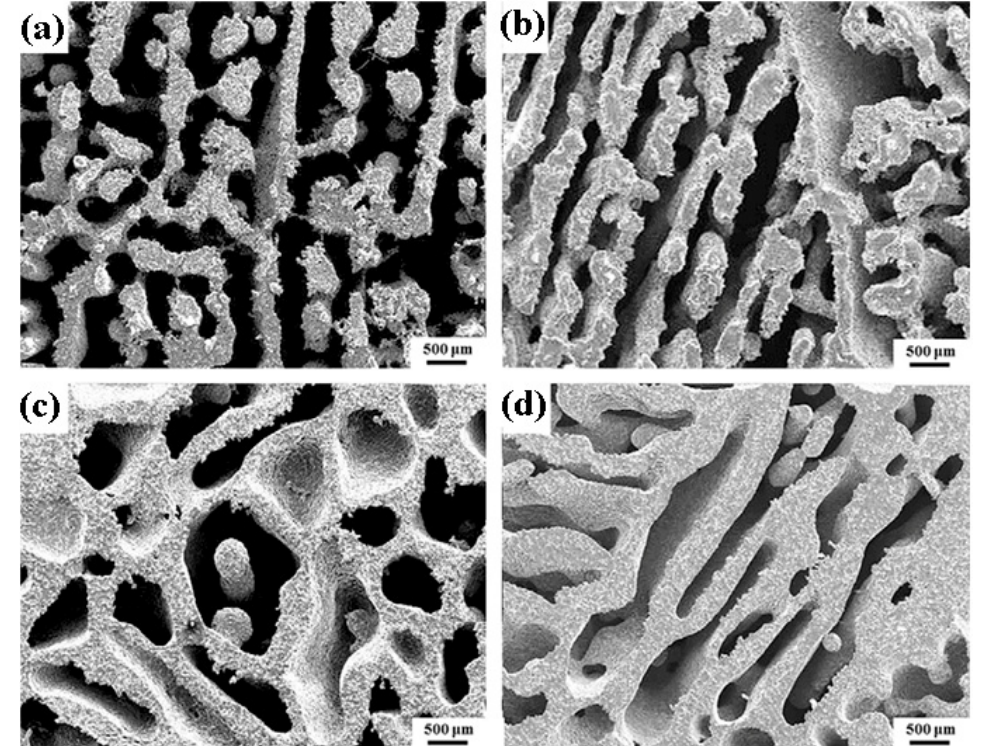
Figure 27. Cross sectional images of aligned porous structures for different casting times: ( a ) 20 h: columnar structure (74%); ( b ) 24 h: co-existing columnar and lamellar structures (69%); ( c ) 36 h: most columnar structures have turned into lamellar structures (59%); ( d ) 48 h: lamellar structure (51%) [299]. Reprinted with permission from [299]. Copyright 2012